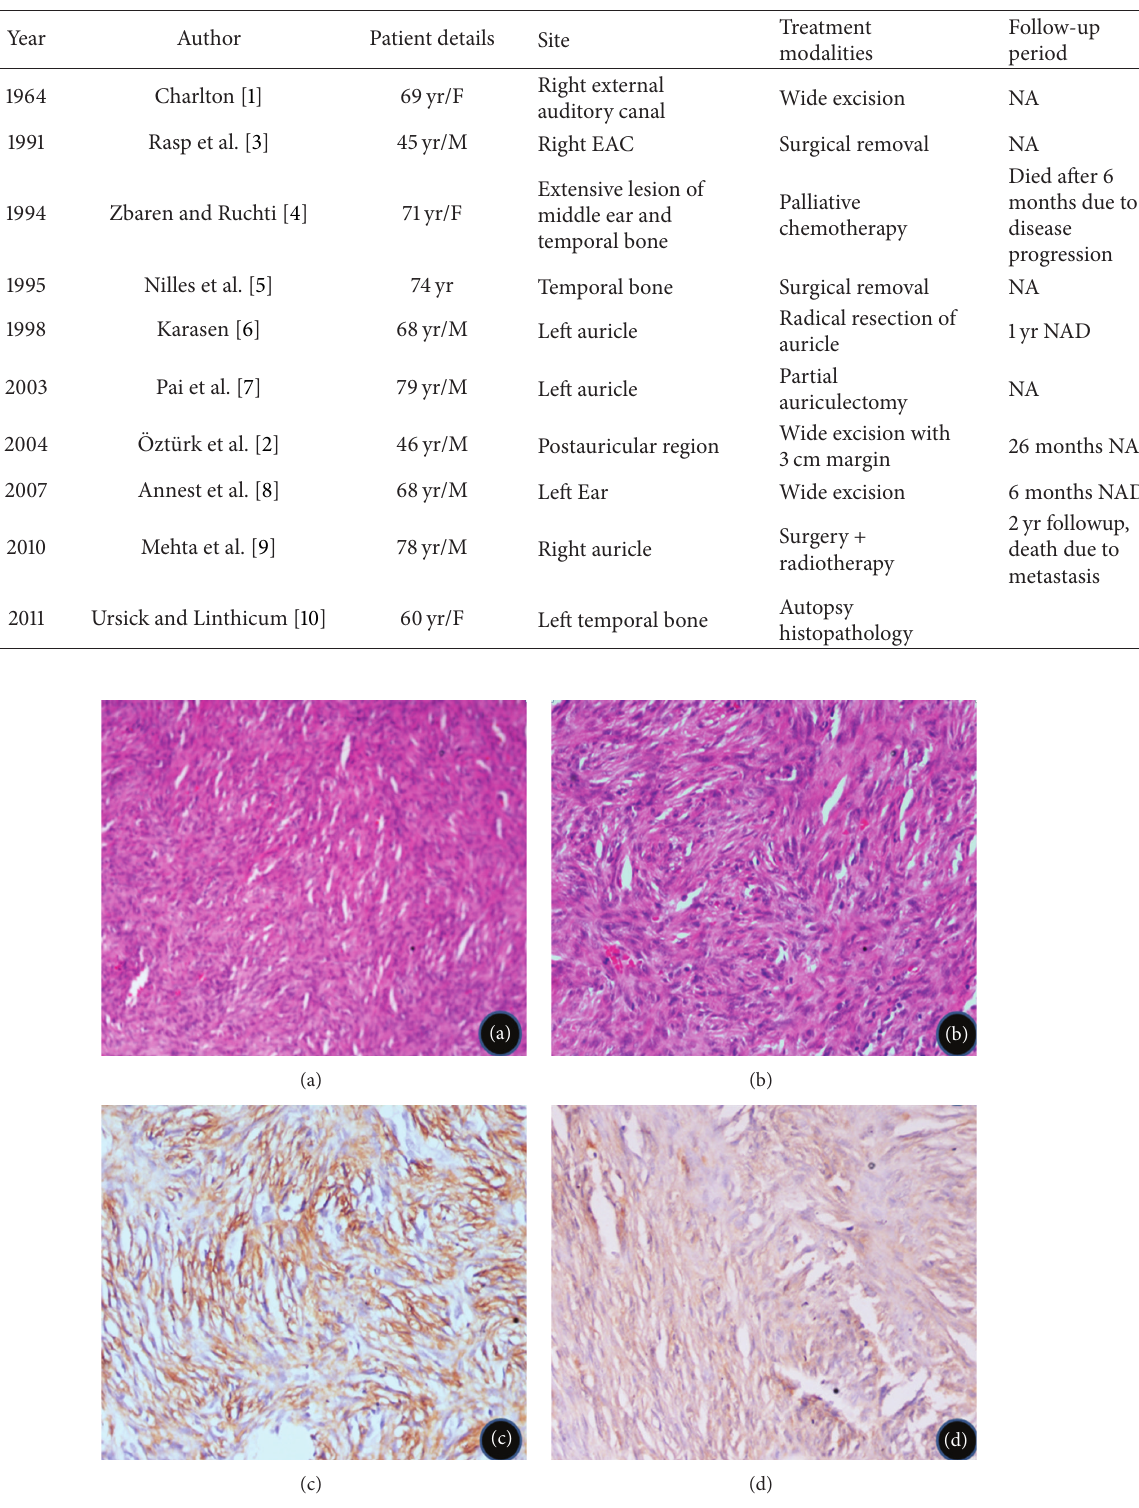
Table 1: Summary of previously reported cases of leiomyosarcoma involving ear/temporal bone.